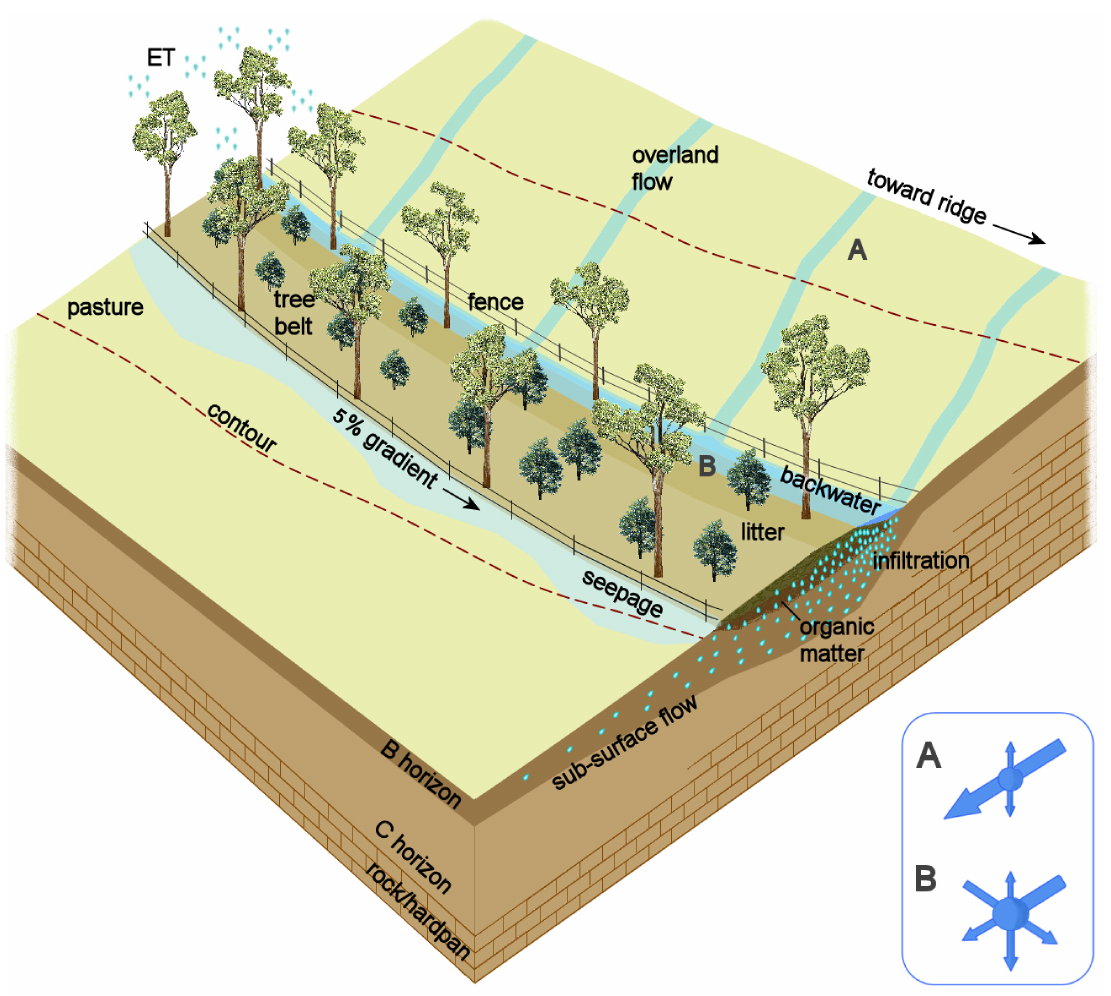
Figure 1. Conceptual model of the integrated vegetation bands (IVB) design and general ecohydrological effects. The inset shows the hypothesised difference in partitioning of overland flow on hillslopes between ( A ) pasture, or ( B )